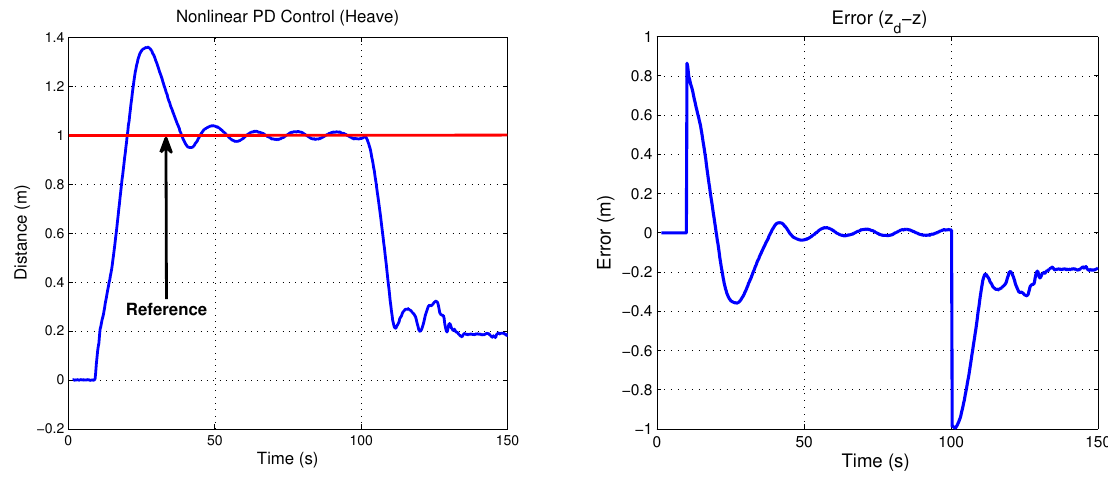
Figure 13. Experimental heave movement and its signal of error in regulation.